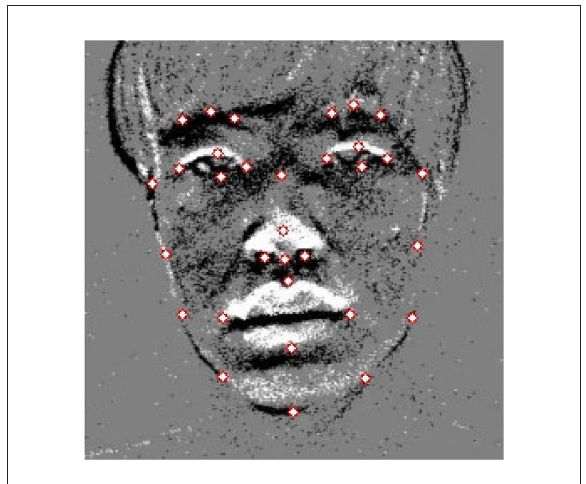
FIGURE4 Facial feature points (face contour: 9 points, eyebrows: 3 points, eye contour: 4 points, nose: 5 points, lip: 4 points).